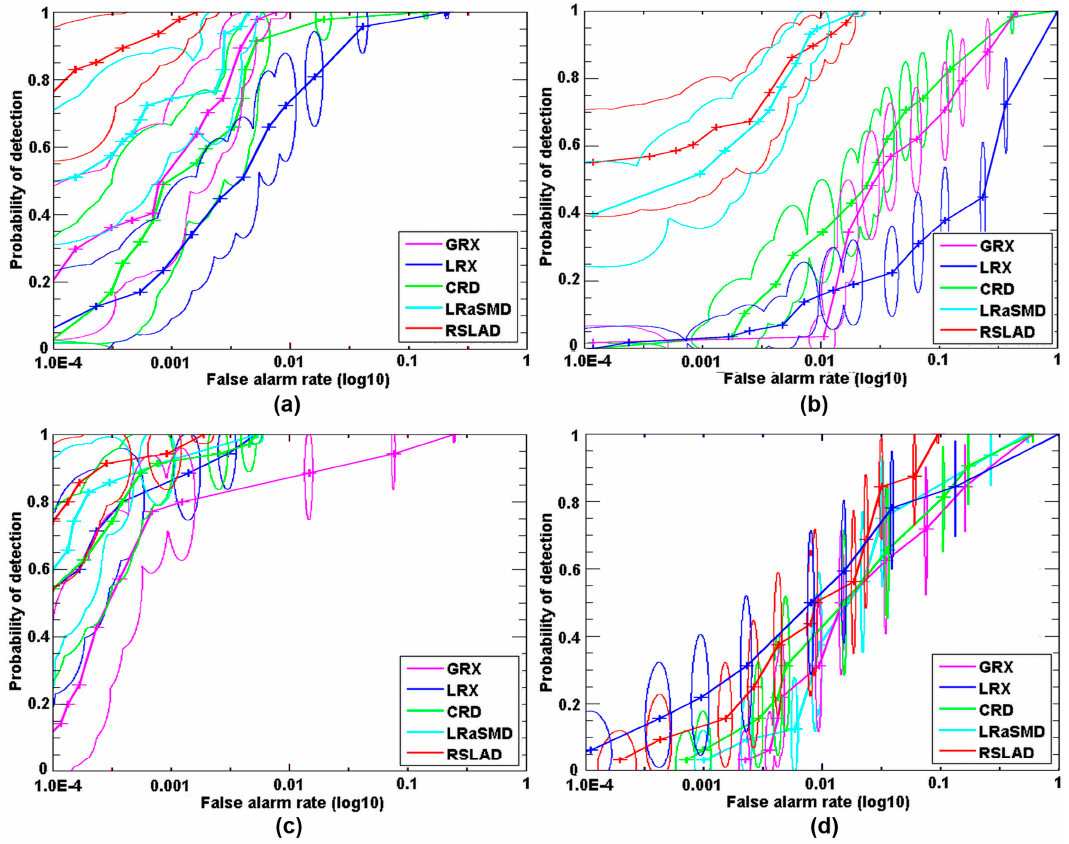
Figure 7. The logarithmic receiver operating characteristic (ROC) curves and confidence regions on the four HSI datasets: ( a ) PaviaC; ( b ) San Diego; ( c ) Botswana; and ( d ) HyMap.